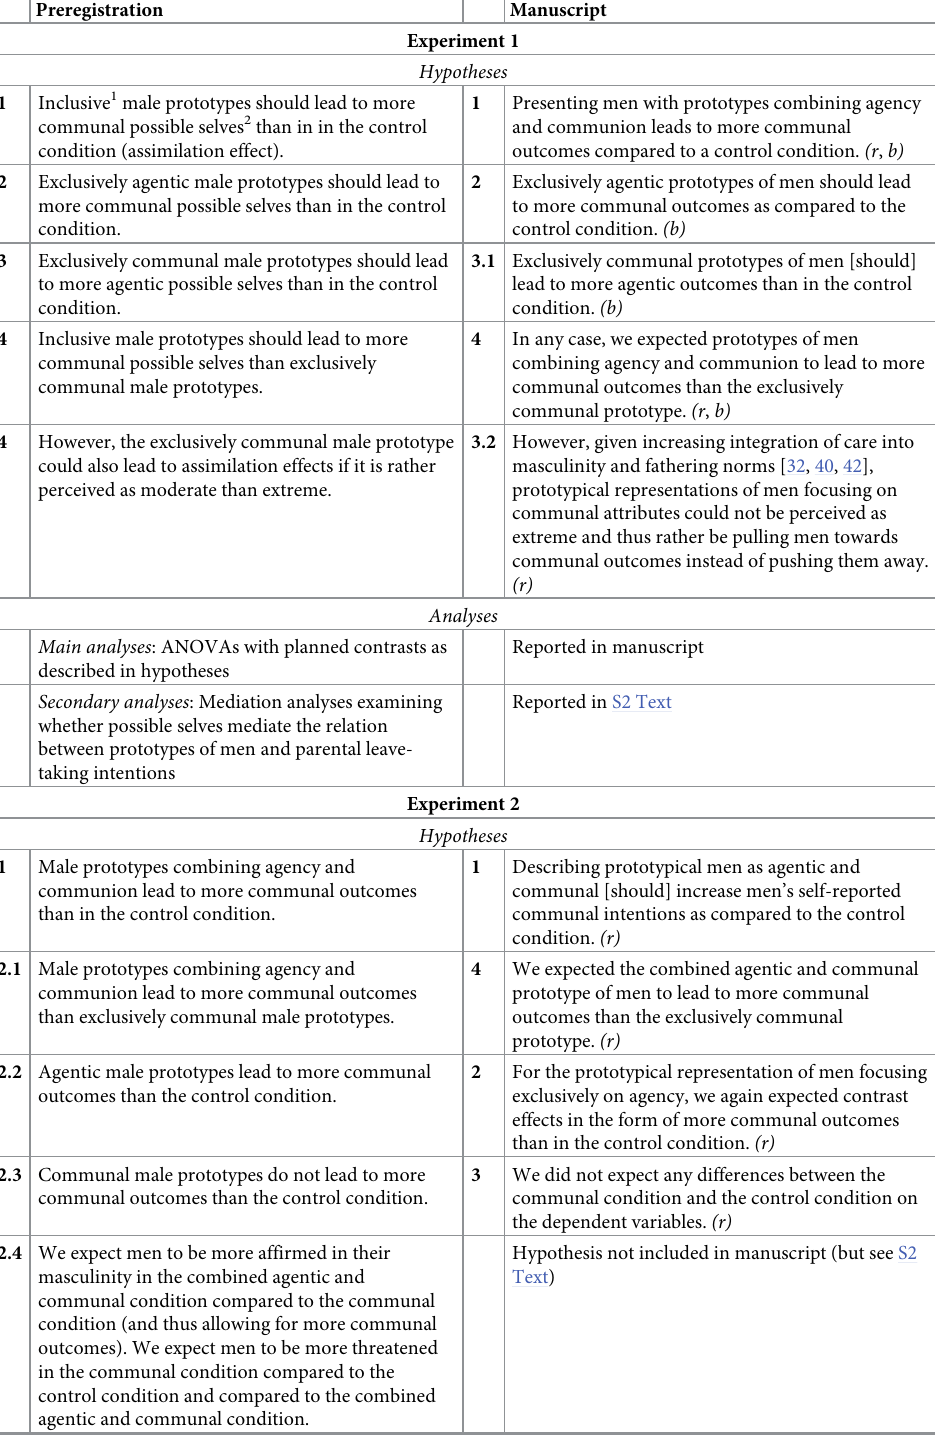
Table 1. Juxtaposition of hypotheses and analyses as presented in the preregistration in comparison to the manu- script for Experiments 1 and 2 (R = rephrased, B =